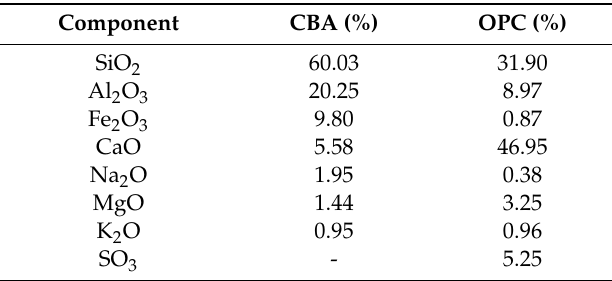
Table 2. Chemical components of CBA and OPC.